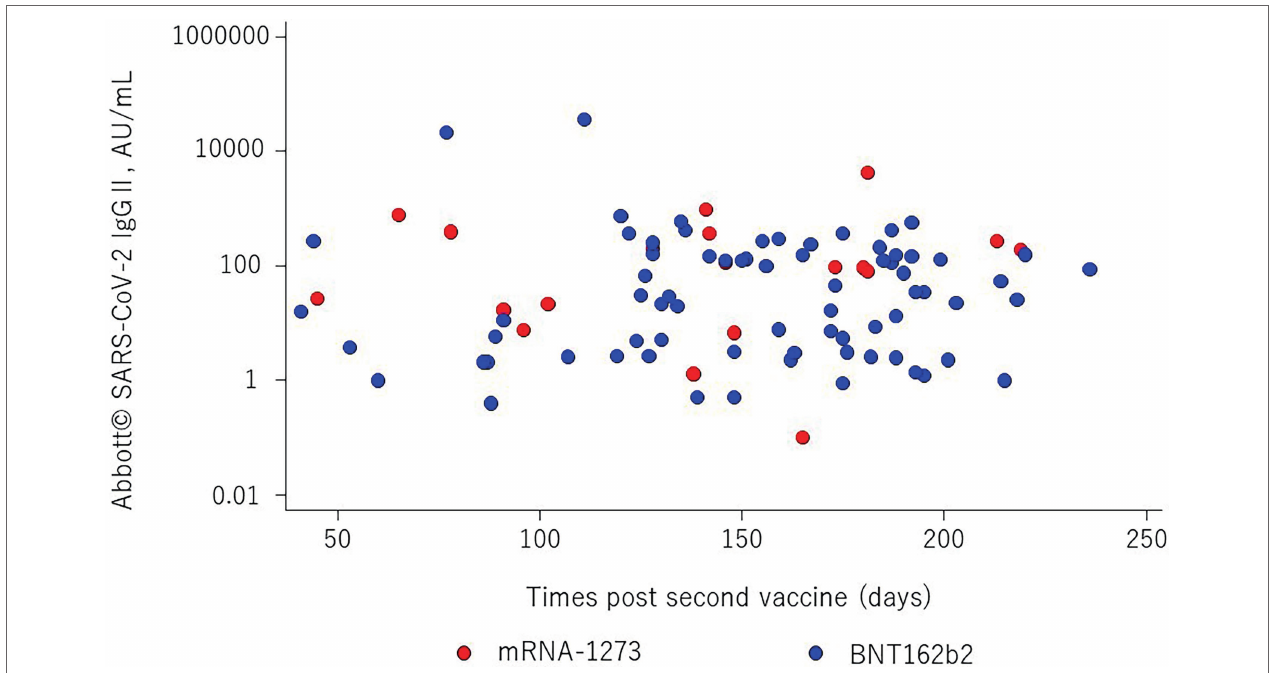
FIGURE 1 | The relationship between SARS-CoV-2 IgG II antibody titers and times post second vaccine (days). The red and blue dots show mRNA-1,273 and BNT162b2, respectively. There is no statistical difference between two vaccines ( p =